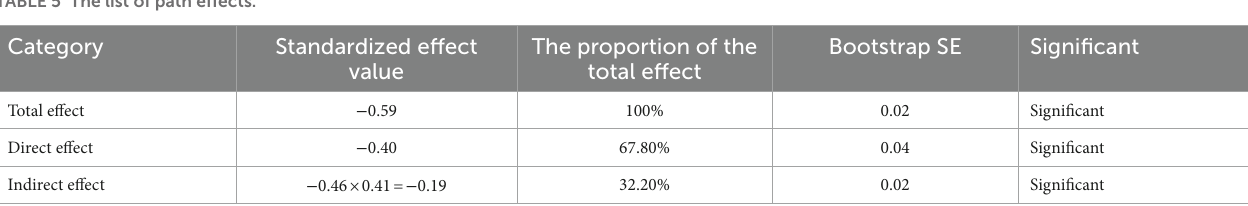
TABLE 6 Linear regression analysis of self-efficacy between low physical exercise amount and learning burnout ( n = 240).